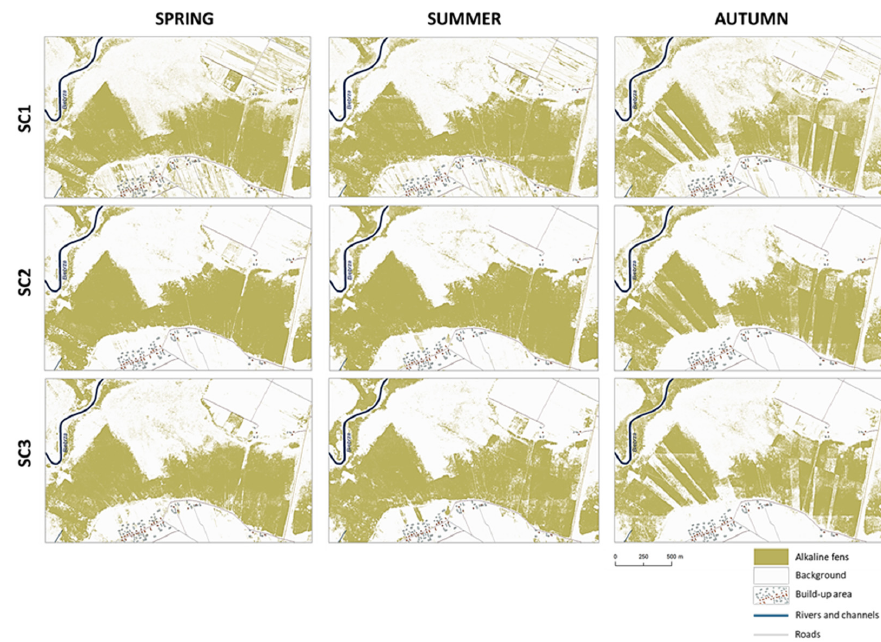
Figure 6. An Example of comparison of classification results for alkaline fens in the UB area in spring, summer, and autumn campaigns for three scenarios in level 1 (SC1, SC2, and SC3).